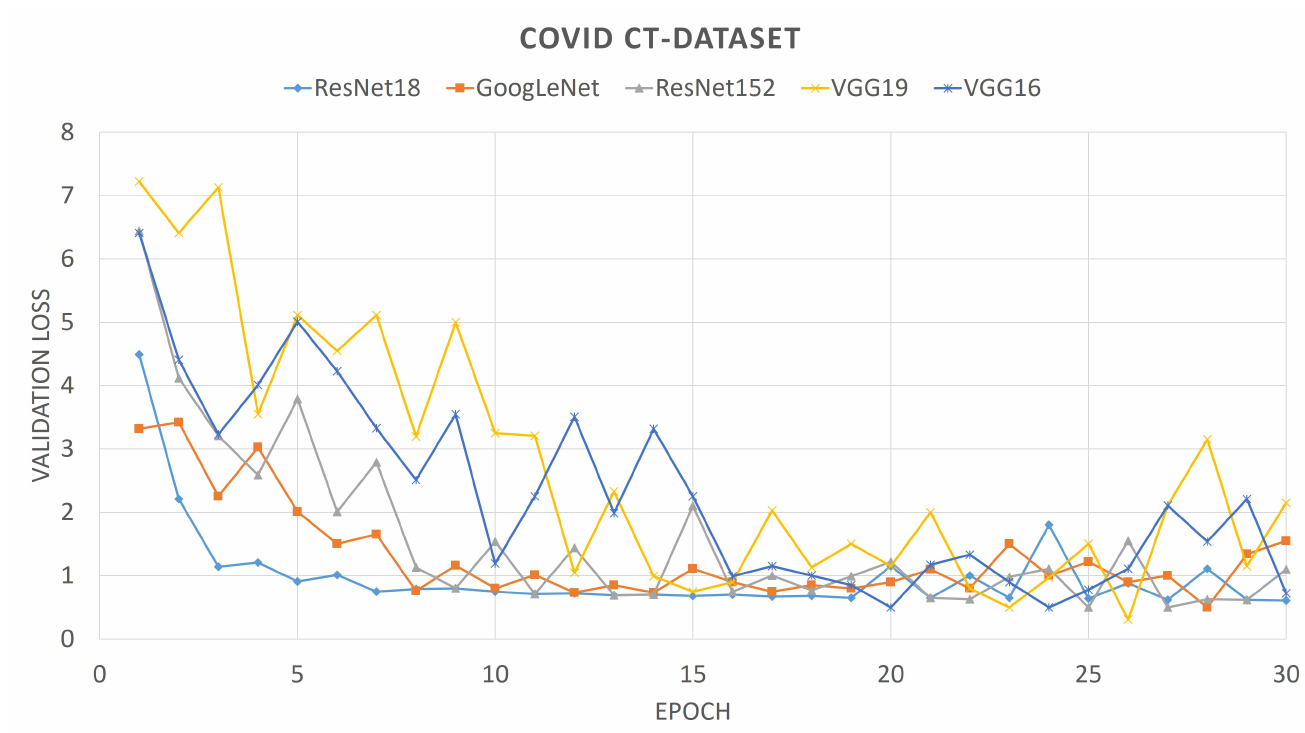
Figure 7. Loss plot of different pre-trained CNNs on SARS-Cov-2 dataset.